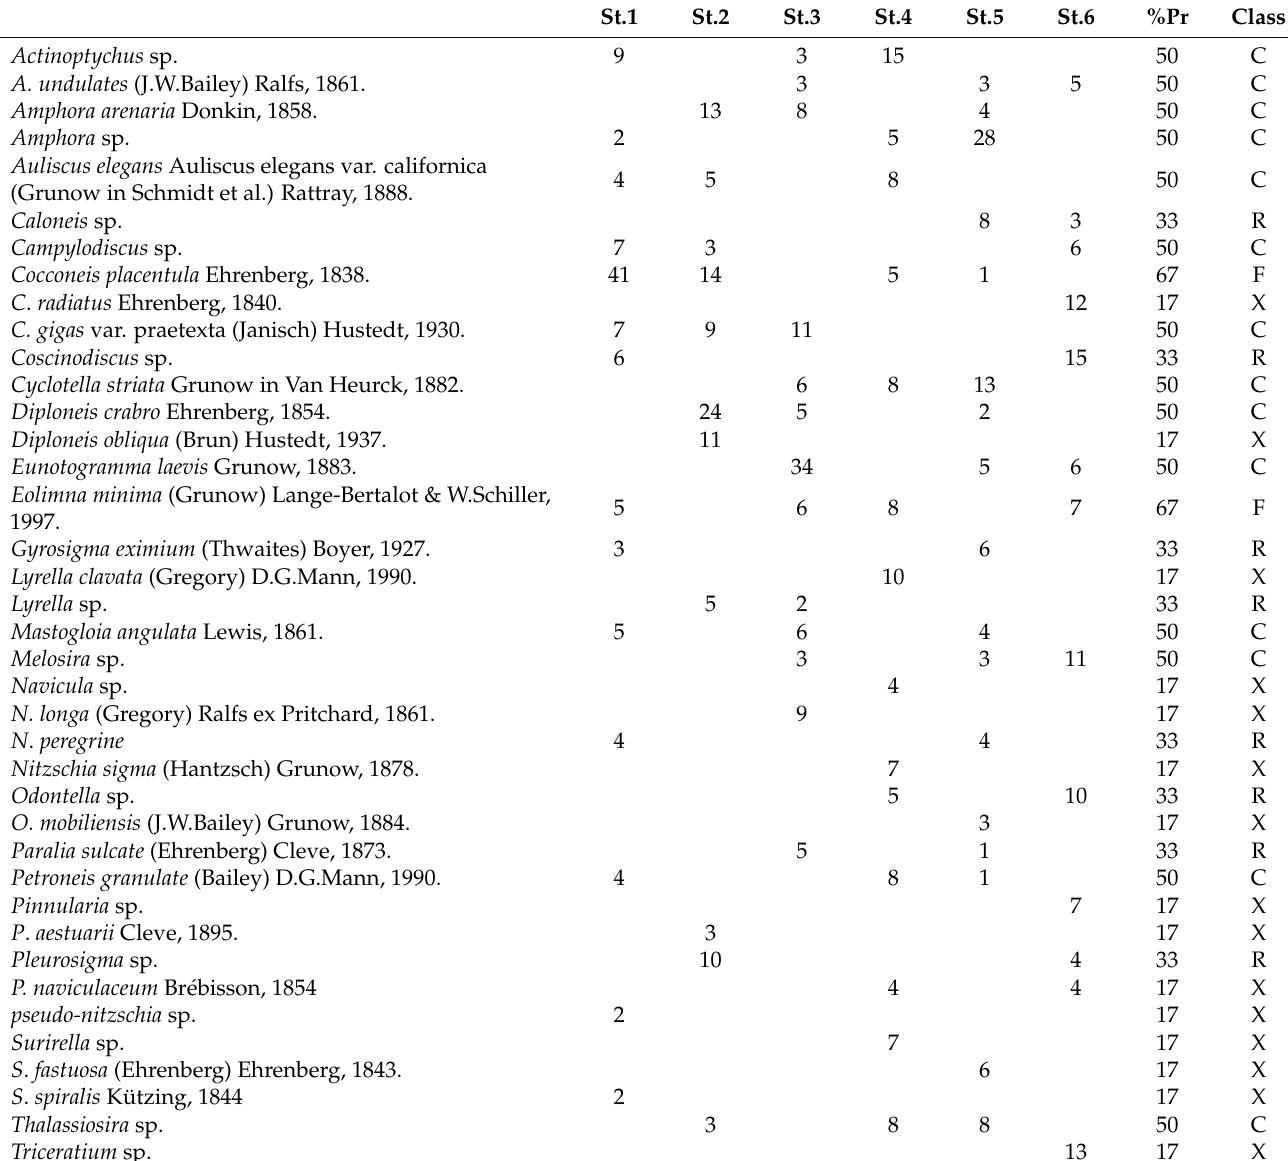
Table 1. List of epipelic diatoms species predominance (%) at the sampling stations along Port Dickson coast, Malaysia. Occurrence (%Pr): 0–20 (sporadically, S); 21–40 (rarely, R); 41–60